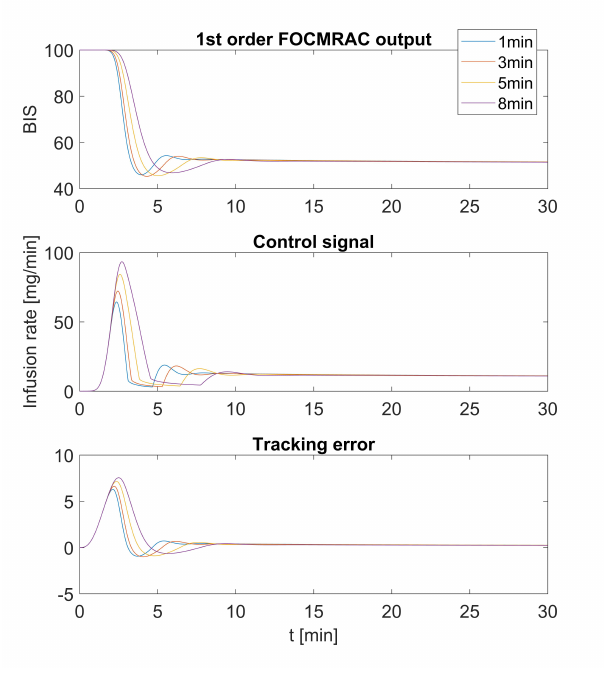
Figure 22. BIS response of patient 1 with different time delays using the 1st-order FOCMRAC